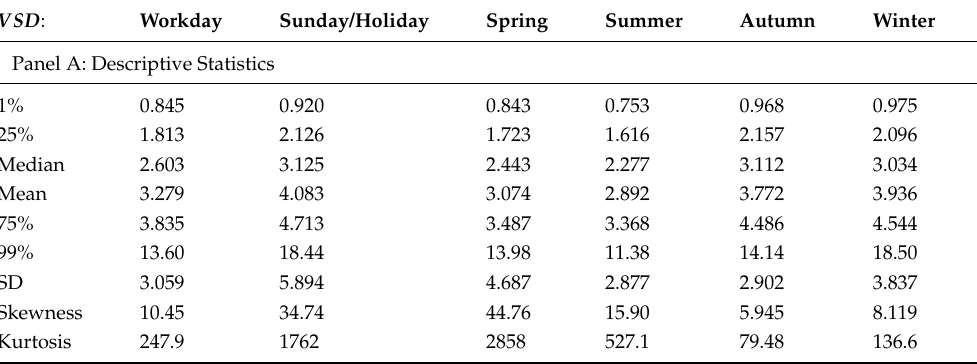
Table 6. Results for the volume-weighted average standard deviation VSD as the dependent variable, separated by season and day. Panel A contains the descriptive statistics, and Panel B contains the regression results. Wind is the relative wind share of the total consumption, Trading is the traded volume of the intraday market in GWh, Foreign is the relative share of the volume (buy and sell) traded between Germany and a foreign country and the total traded volume of the intraday market, and ∆ Price is the absolute price difference of the day-ahead auction price and the volume-weighted average intraday price. RMSE is the root mean squared error, and MAE is the mean absolute error. The asterisks denote the significance level with *** =